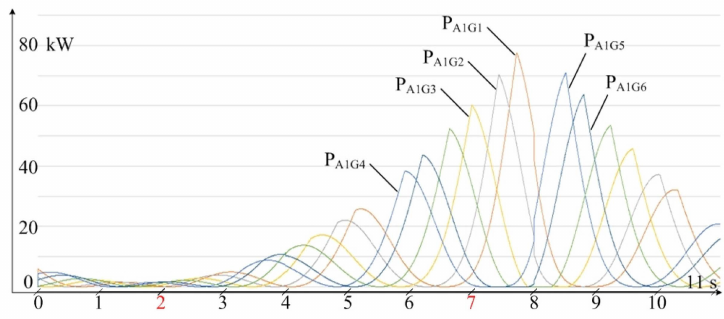
Figure 13. Output profile of wave generators in array 1. P AlG n : real power output of generator n in array l.